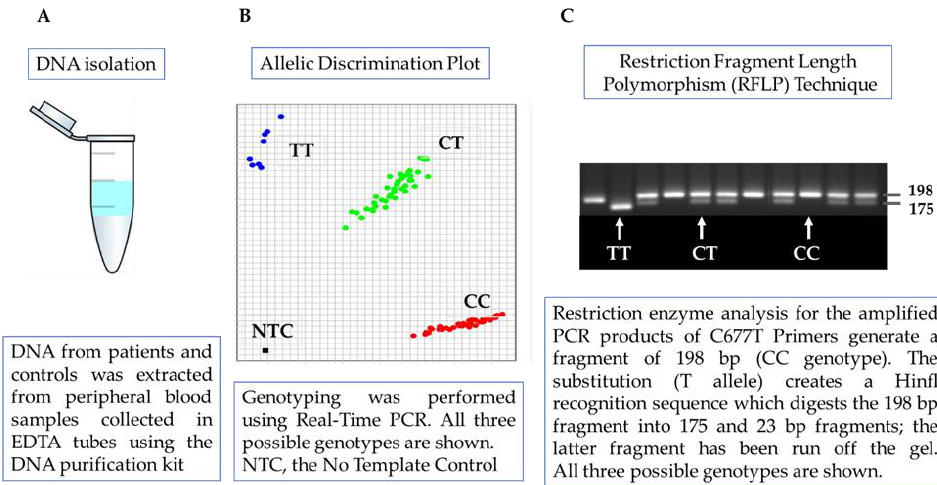
Figure 1. The design of the experiment: ( A ) DNA isolation. ( B ) The Real-Time PCR method. ( C ) Polymerase chain reaction (PCR) followed by restriction digestion analysis (own measurements).